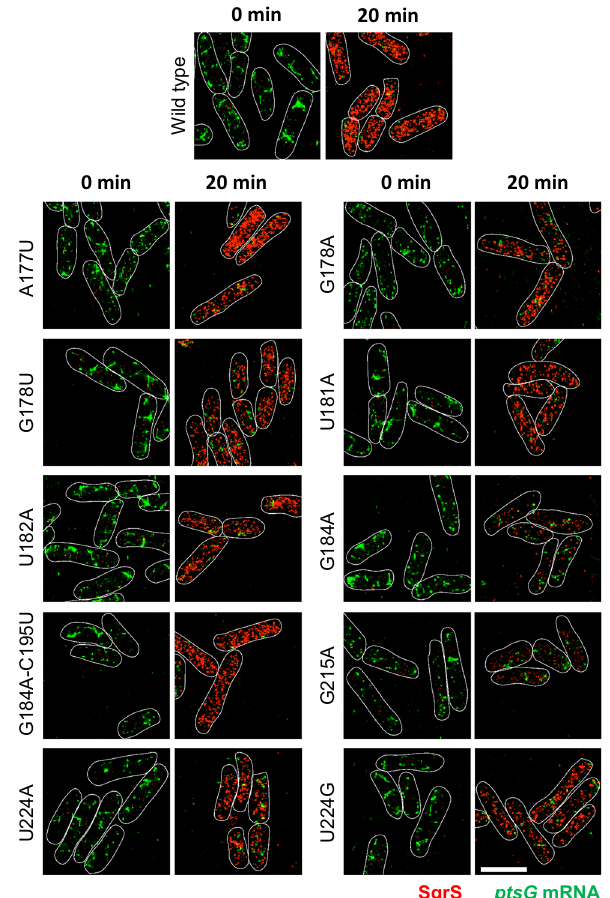
Fig. 4 3D super-resolution images projected in 2D planes. The panels show SgrS (red) and ptsG mRNA (green) labeled by smFISH for the wild- type and the mutant strains, A177U, G178A, G178U, U181A, U182A, G184A, G184A – C195U, G215A, U224A, and U224G before and after 20 min of α MG (non-metabolizable sugar analog) induction. Each experiment was performed independently two times. Cell boundaries are denoted by white solid lines. Scale bar is 2 μ m and applies to all the